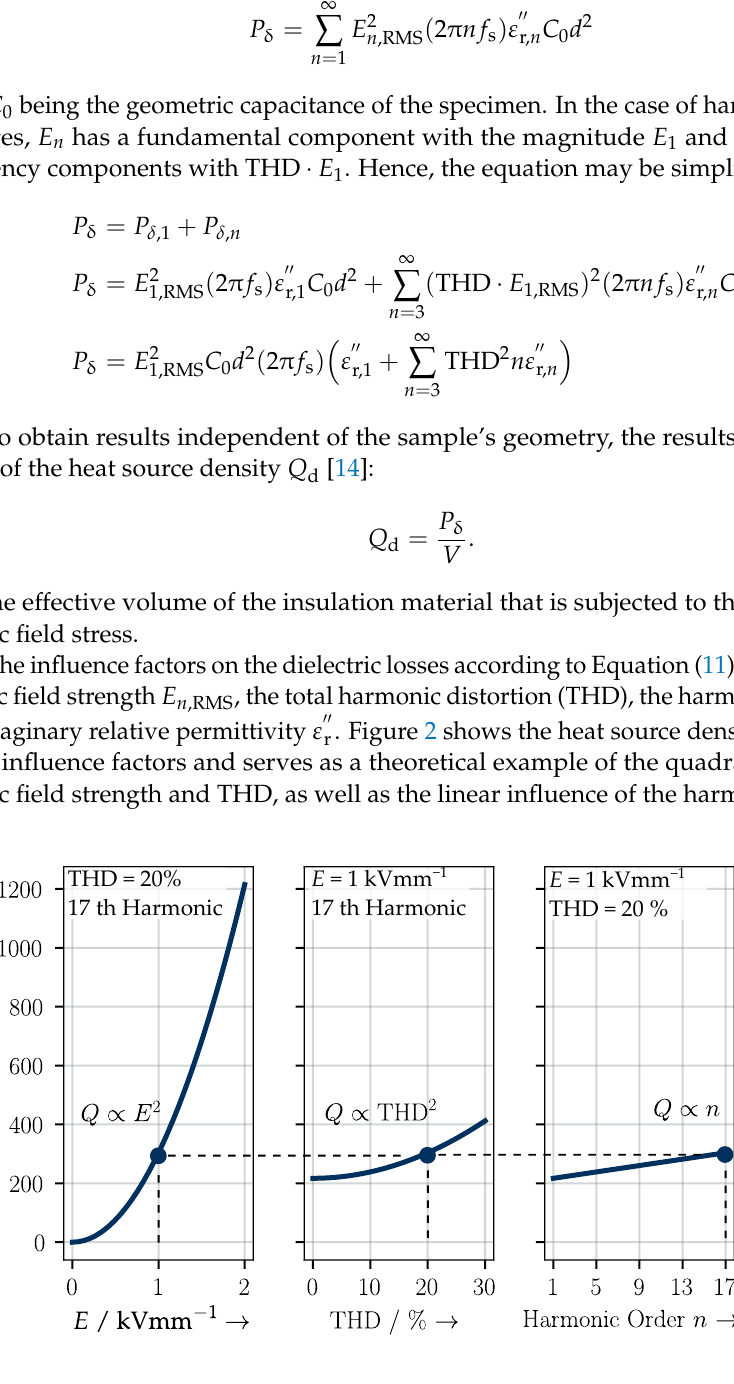
Figure 2. Heat source density of dielectrics as a function of different influence factors according to Equation